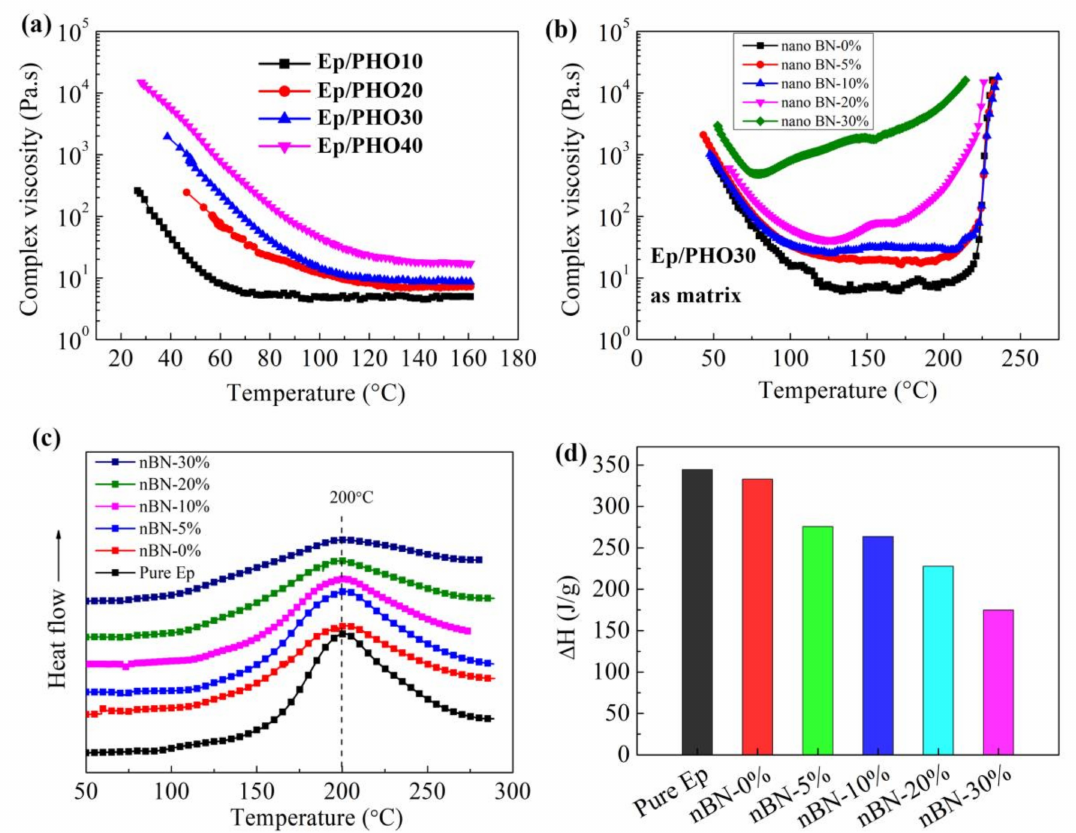
Figure 1. ( a ) Viscosity–temperature curves of Ep/PHO blends, ( b ) viscosity–temperature curves of the thermally conductive adhesive systems, ( c ) DSC curves of the adhesive systems, ( d ) the reaction enthalpy of the adhesive systems.